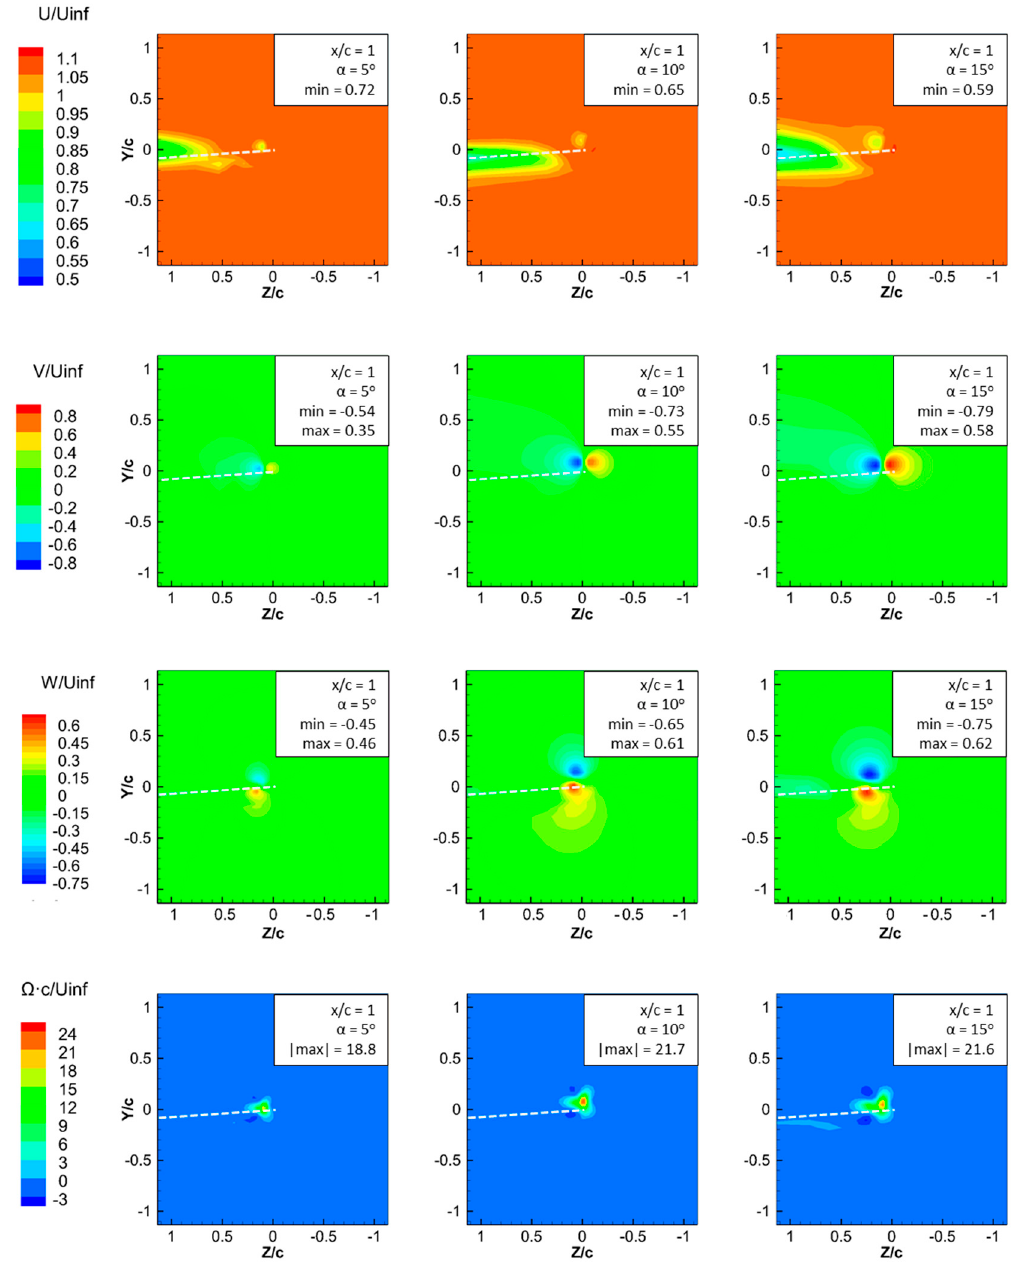
Figure 9. Time-averaged axial, normal and spanwise velocity, and vorticity contours at the wingtip. Comparison between various angles of attack.